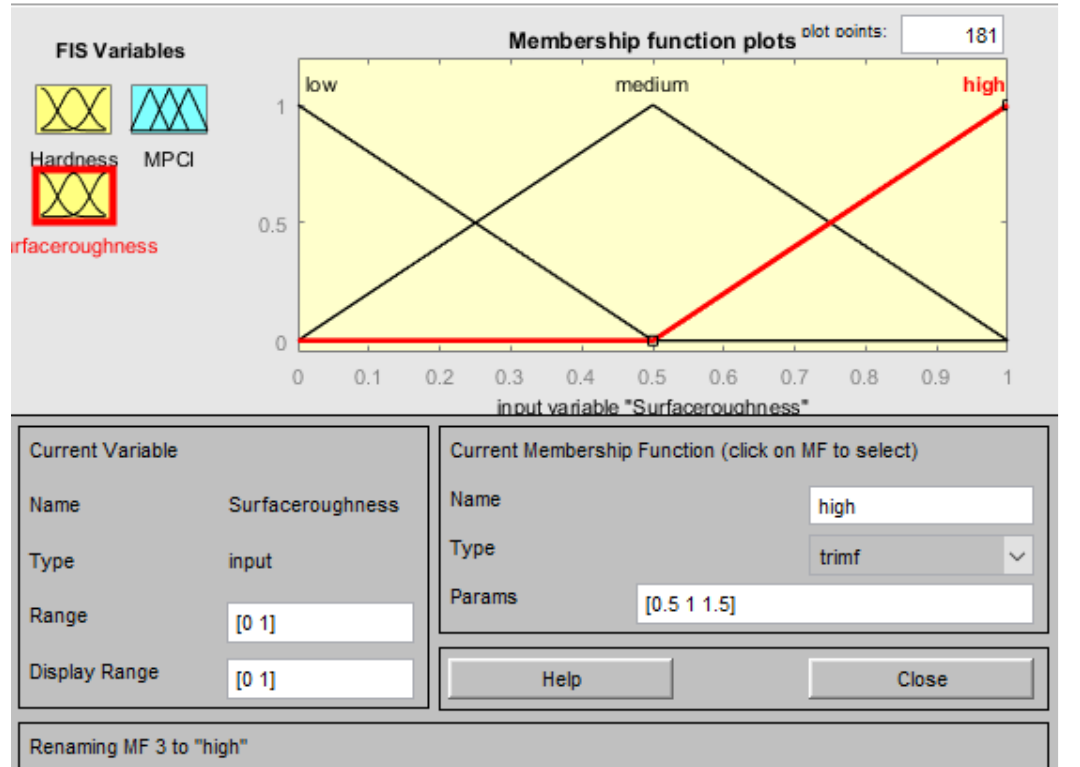
Figure 8. Membership function for the surface roughness.